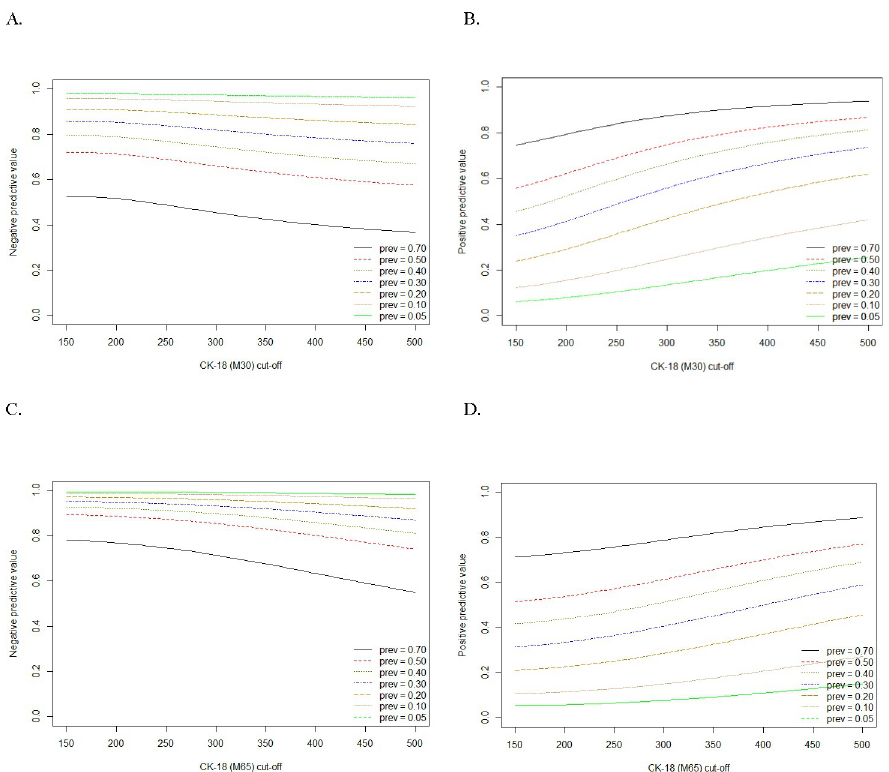
Fig 3. Positive and negative predictive values and thresholds for detecting NASH. Plots illustrating the negative and positive predictive values of M30 (A-B) and M65 (C-D) in detecting NASH at corresponding threshold values, projected by the multiple thresholds model. Each colored line represents a different prevalence setting, ranging from 5% to 70%. The y-axis indicates the predictive value and the x-axis indicated the threshold values for CK-18.